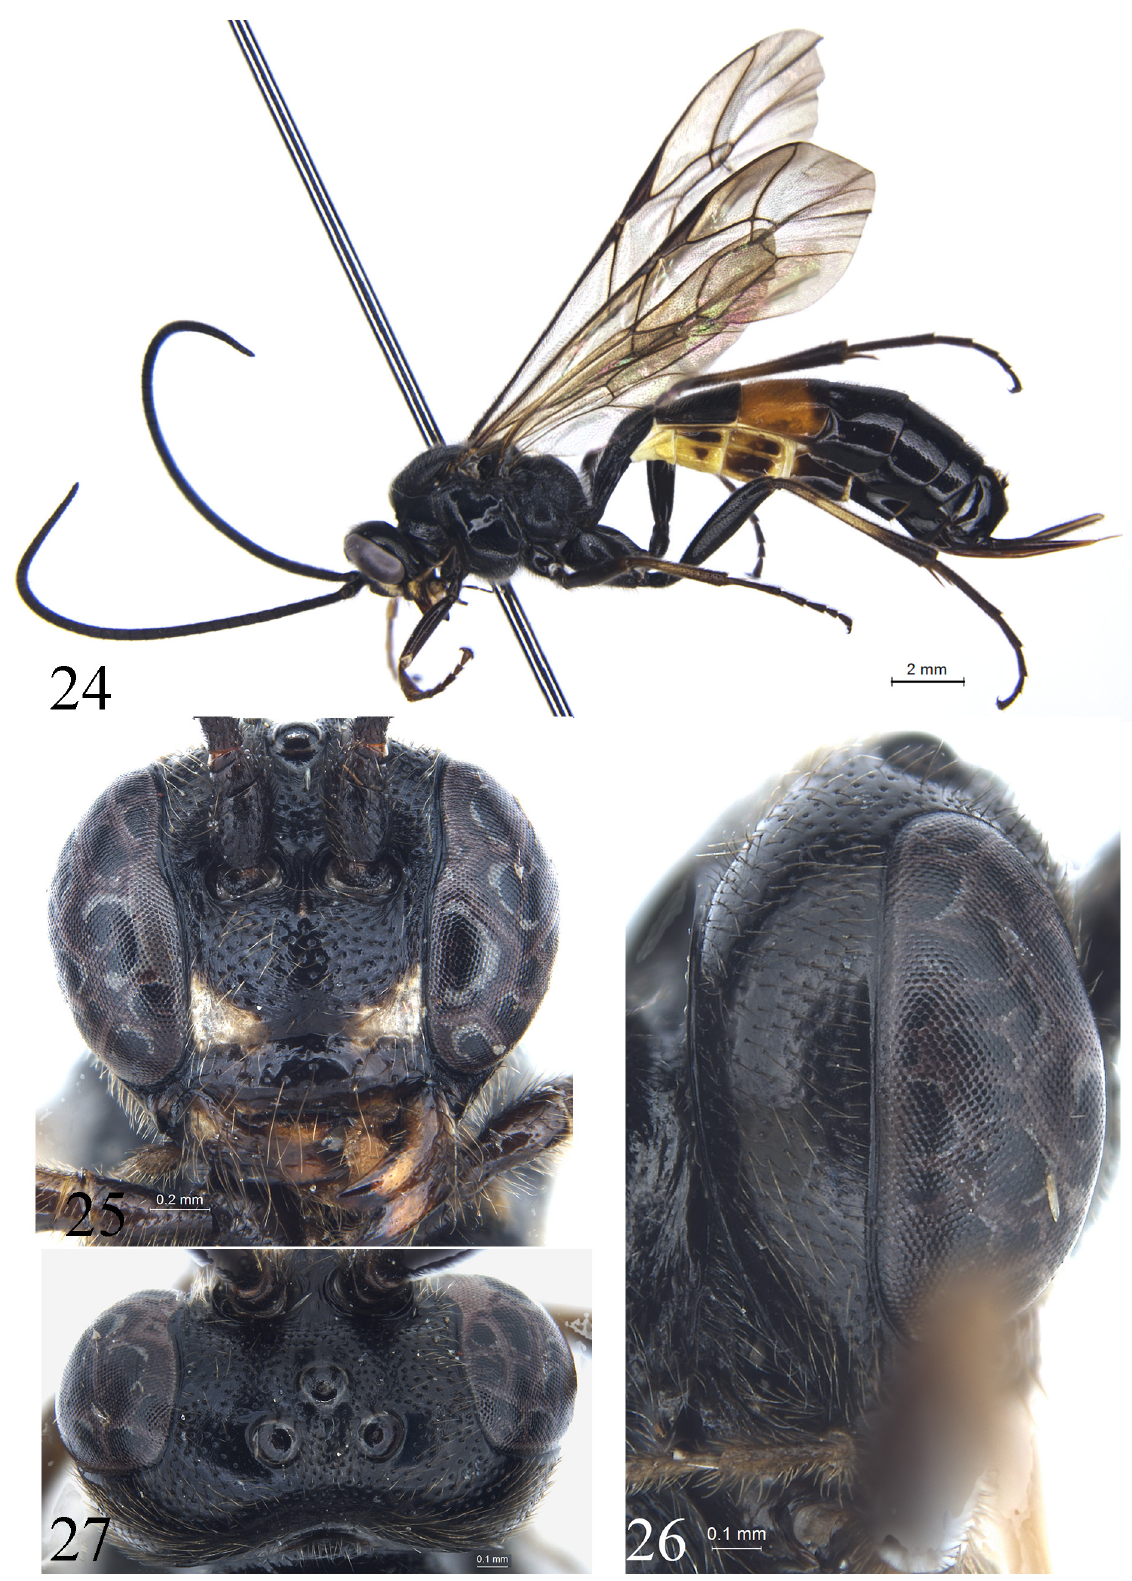
Figs 24–27. Ctenopelma rufofasciatum Sheng, Sun & Li sp. nov., holotype, ♀ (GSFGPM). 24 . Habitus, lateral view. 25 . Head, anterior view. 26 . Head, lateral view. 27 . Head, dorsal